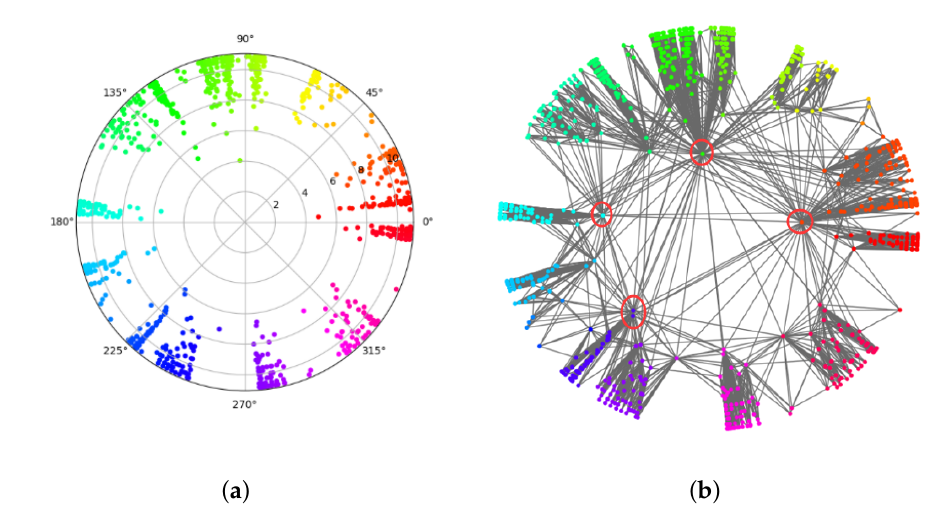
Figure 6. The community discovery visualization of nPSO-1 based on hyperbolic embedding. ( a ) shows the hyperbolic coordinates of the network, and ( b ) shows the result of community discovery using the CGM algorithm based on the coordinates in ( a ). We circled some key nodes which connect with many nodes, and we can see they usually have small radial coordinates in hyperbolic space.